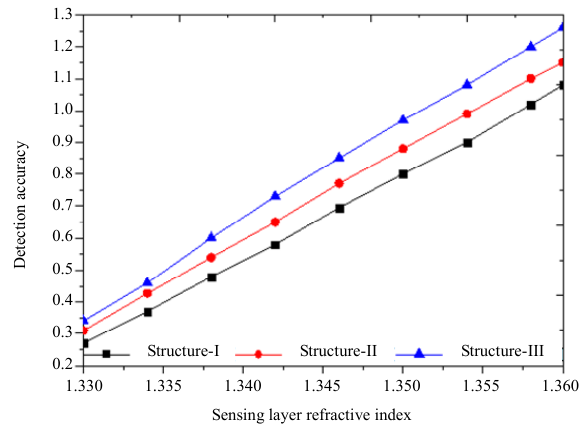
Fig. 4 Variation of the detection accuracy as a function of the sensing layer refractive index for structure-I, structure-II, and